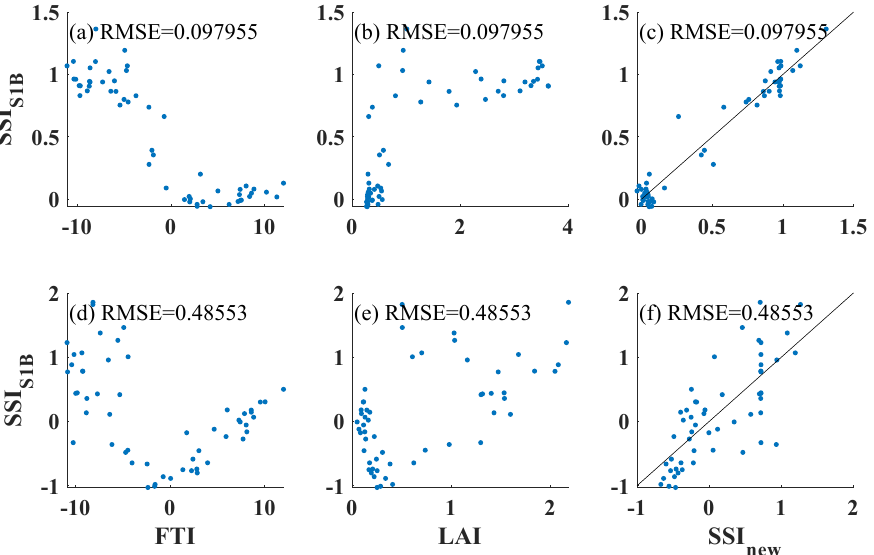
Figure 17. Two examples of the scatter plot among the SSI S1B , FTI, LAI, and SSI new with lower RMSE ( a – c ) and higher RMSE ( d – f ) from the Genhe watershed. The high consistency of the surface F/T state between the S1 and AMSR2 overpass times would decide the basis for algorithm development. As shown in Table 2, the over- pass time of S1B over the Genhe watershed (22:00) differs the most from that of AMSR2 (1:30). To combine S1B and AMSR2 to detect the surface F/T state, an analysis was per- formed to determine the difference in surface F/T indicated by the in situ 5 cm soil tem- perature between 10:00 PM and 1:30 AM over the Genhe watershed. Figure 18 shows the comparison of in situ 5 cm soil temperature between 10:00 PM and 1:30 AM over culti- vated land, grassland, and forest in the Genhe watershed. The temperatures between the